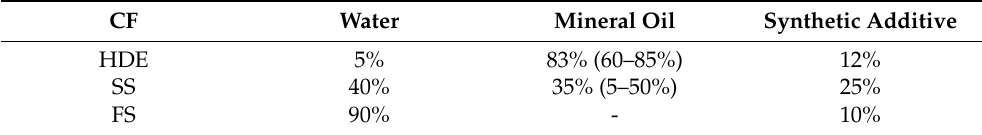
Table 5. Composition of neat concentrate of each CF group. CF Water